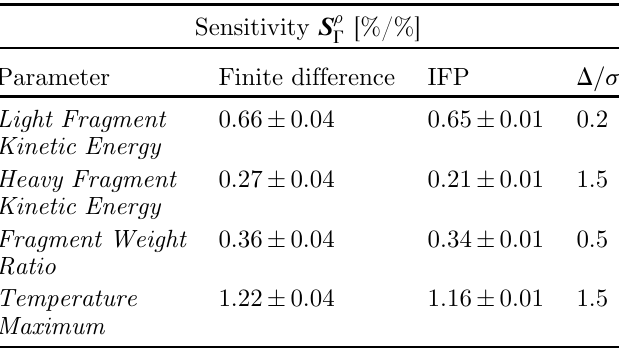
Table 5. PMF001 reactivity sensitivities to